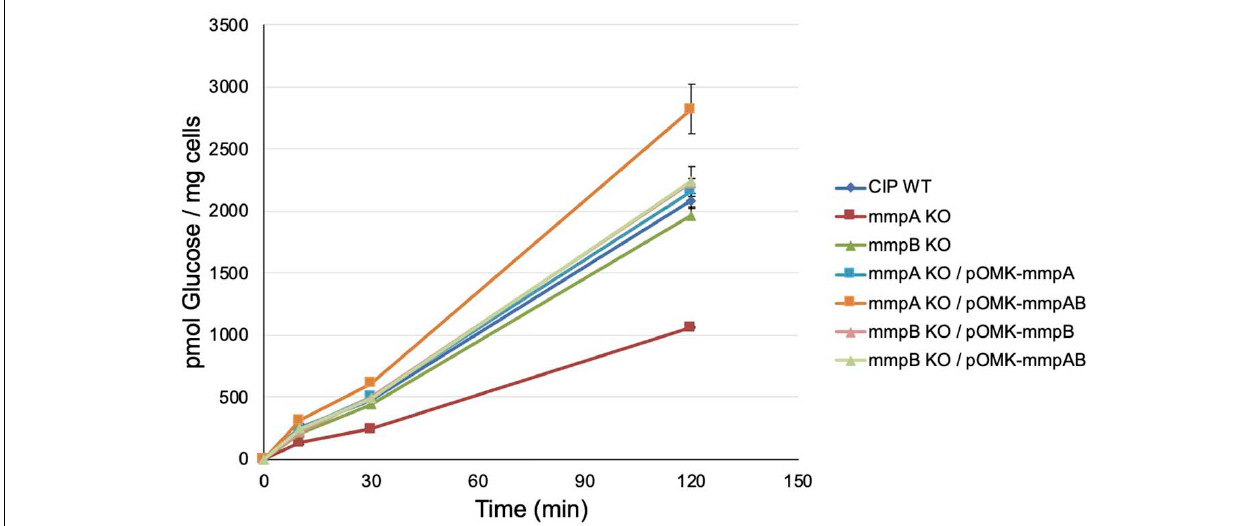
FIGURE 5 | Glucose uptake by wild-type Mmas , the mmpA and mmpB knock-out mutants and the complemented porin mutant strains. The accumulation of [U- 14 C]glucose by the strains over time was measured as described (Calado Nogueira de Moura et al., 2014). Glucose uptake was measured in duplicate samples and the average values are shown with their standard deviations. Glucose uptake rates were calculated on the first 120 min of the reactions.